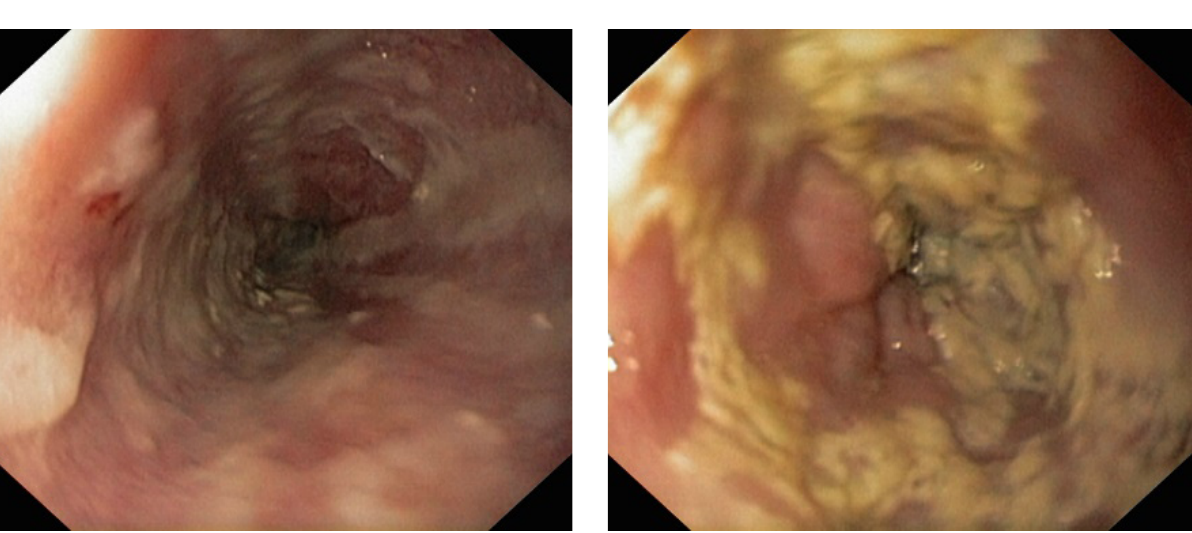
Fig. 2. Exfoliative esophagitis. Fig. 3. Esophageal